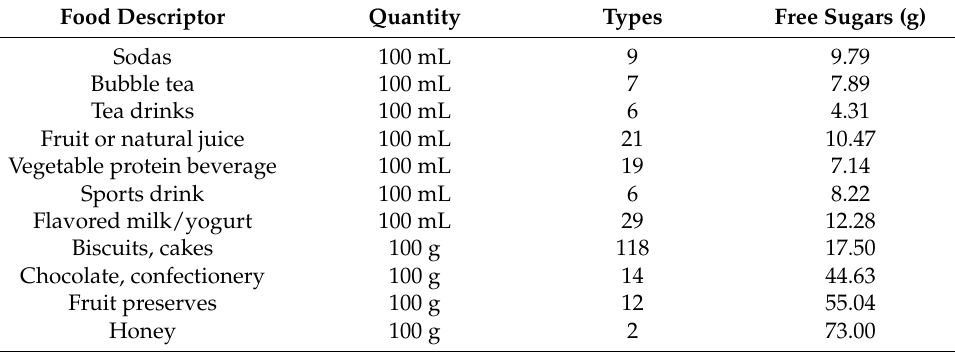
Table A1. Food item, weight, and free sugars from China